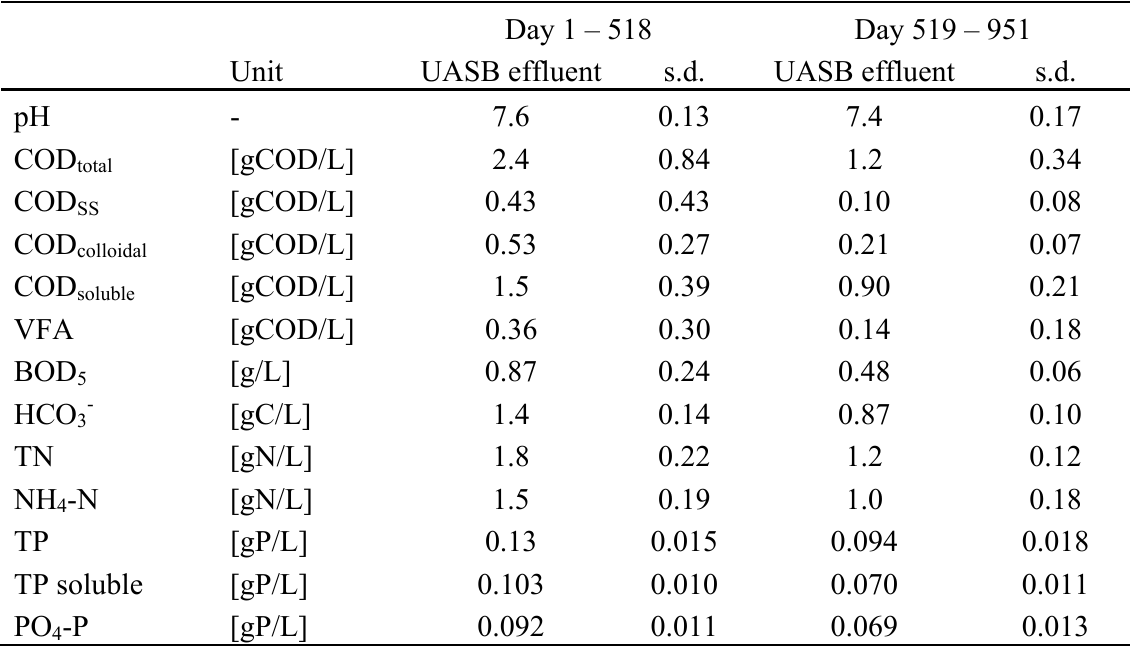
Table 4. UASB effluent